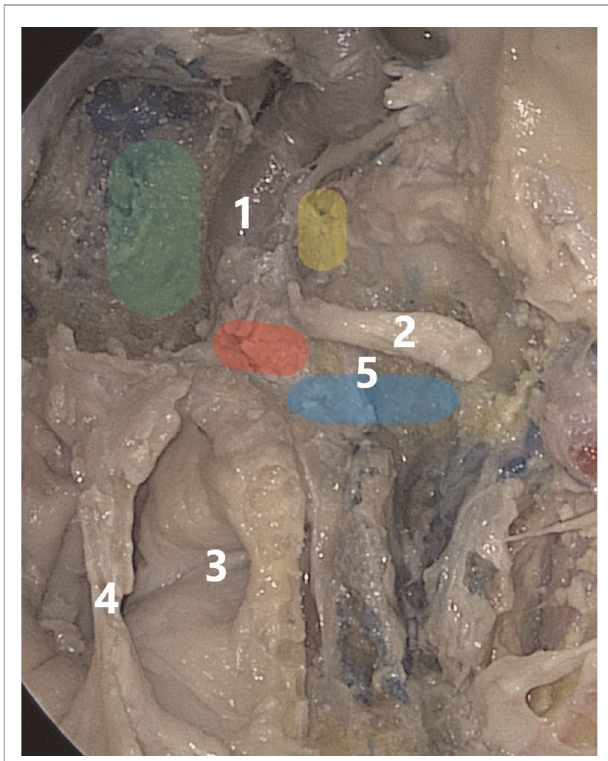
FIGURE 3 | Area highlighted in green is the group of medial approaches, that in red is the area of the lacerated foramen, that in yellow is the access to the Meckel cavity, and that in blue is the group of infrapetrosal approaches; 1 — internal carotid artery, 2 — Vidian nerve, 3 — pharyngeal mouth of the auditory tube, 4 — posterior sections of the vomer, 5 — base of the pterygoid